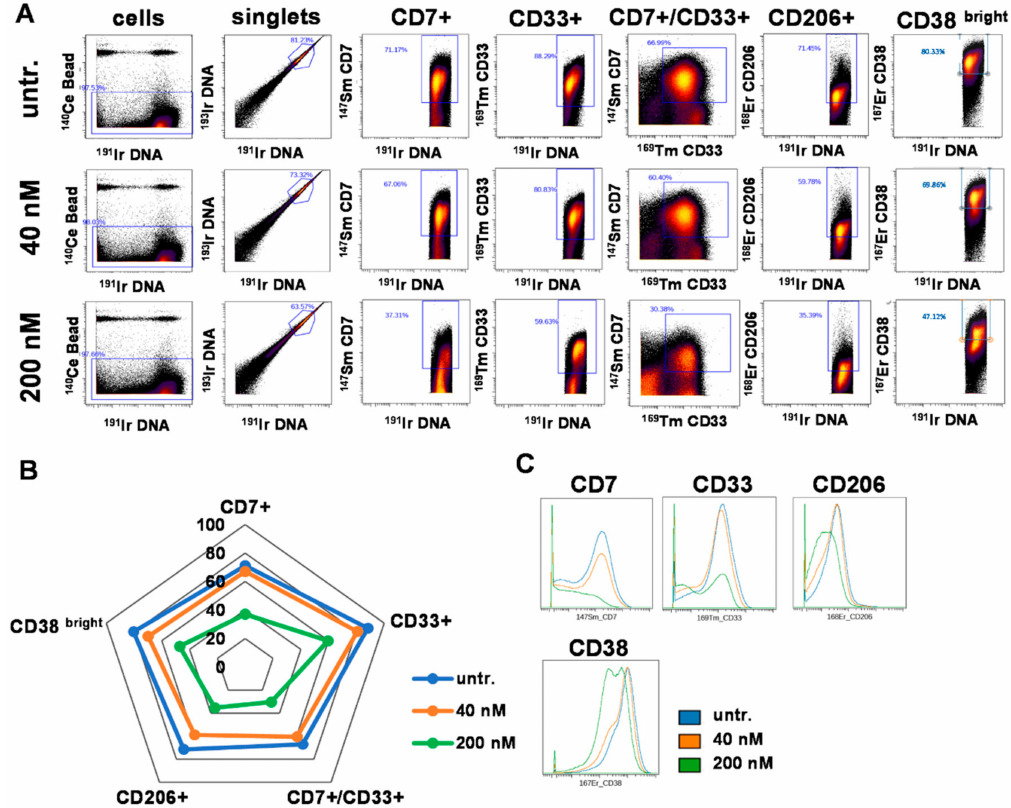
Figure 7. The percentage of CD7 + , CD33 + , CD7 +/ CD33 + , CD206 + , and CD38 bright human AML2, patient-derived bone marrow aspirate cells decreased after the treatment with DU325 ex vivo. Mass cytometry was used for multiparametric immunophenotyping of AML2 patient-derived cells treated by DU325 for 48 h. Gating strategy is presented to define single cells and sub-populations of AML cells ( A ). Gating strategy for 11 additional subpopulations can be found in Figure S8. The pentagram of the population trajectories ( B ) shows the decrease of the percentages of CD7 + , CD33 + , CD7 +/ CD33 + , CD206 + , and CD38 bright AML2 cells treated with 40 nM (orange) or 200 nM DU325 (green) ex vivo for 48 h. The overlay of the histograms demonstrates the lower expression of CD7, CD33, CD206, and CD38 followed by DU325 treatment in nanomolar range ( C